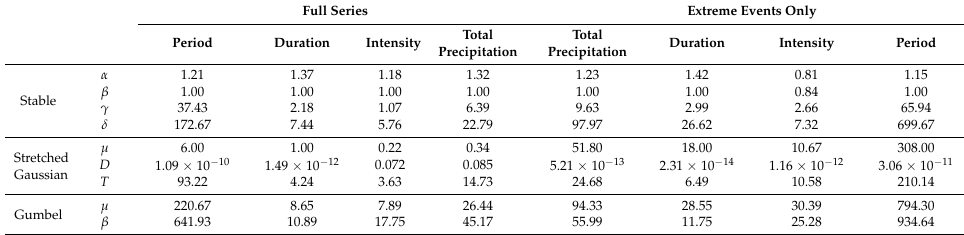
Table 5. The distribution parameters for storm property distribution